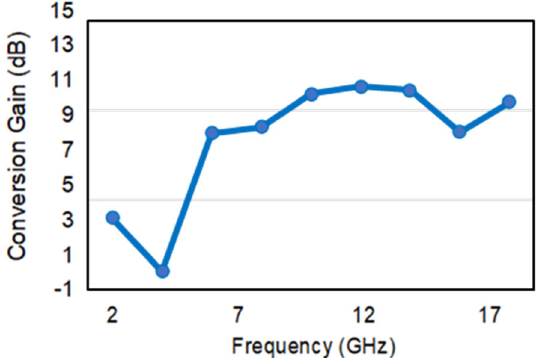
Figure 10. The measured conversion gain of the receiver. The input power is equal to − 30 dBm.